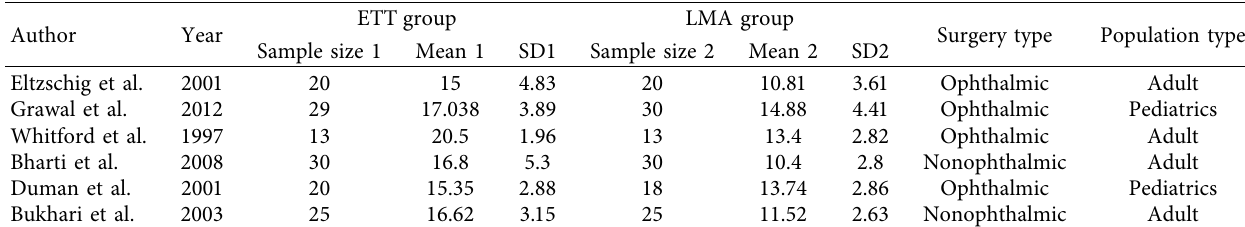
Table 1: Description of the studies included in the meta-analysis before insertion of LMA and ETT intubation. Author Eltzschig et al. Grawal et al. Whitford et al. Holden et al. Duman et al. Bukhari et al.